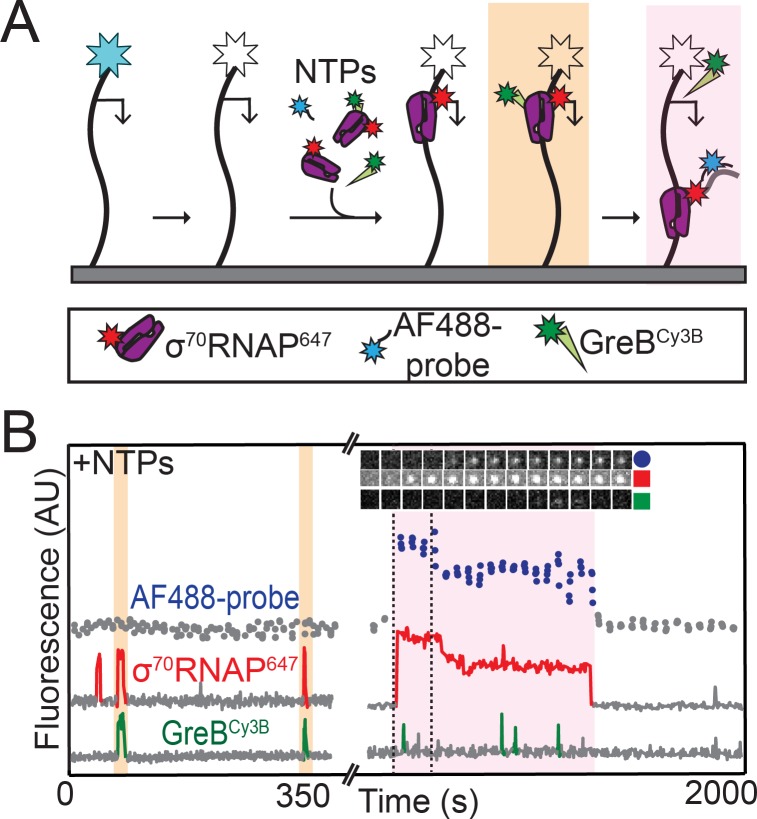
RNAP does not initiate transcription when GreB is bound.(A) Experiment design. Template and labeled proteins were the same as in Figure 3A. DNA was first imaged, then the AF488 dye (blue star) was bleached (white star). Then AF488 oligonucleotide probes and 1 mM NTPs were introduced as in Figure 2, along with 1 nM σ70RNAP647 and 10 nM GreBCy3B. (B) Two excerpts from the record of fluorescence intensities colocalized with one template DNA molecule. Two events in which σ70RNAP647 bound to DNA accompanied by GreBCy3B (orange) and one in which σ70RNAP647 arrived alone (purple) are highlighted. Only the last resulted in transcription initiation as judged by AF488-probe colocalization. Time series images (1.1 × 1.1 µm) from the time interval delimited by dashed lines confirm appearance of co-localized AF488-probe and σ70RNAP647.